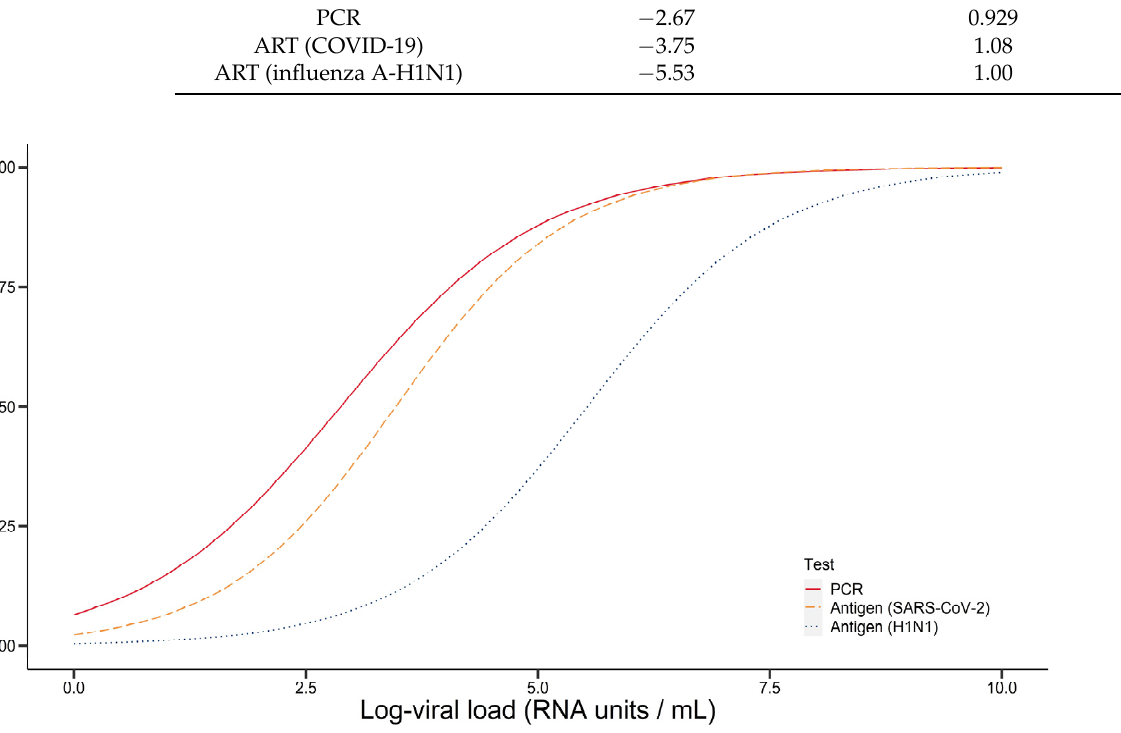
Figure 2. Test sensitivity by log viral load (in RNA copies/mL) for PCR (red solid), antigen for SARS-CoV-2 (orange dashed) and antigen for influenza A-H1N1 (blue